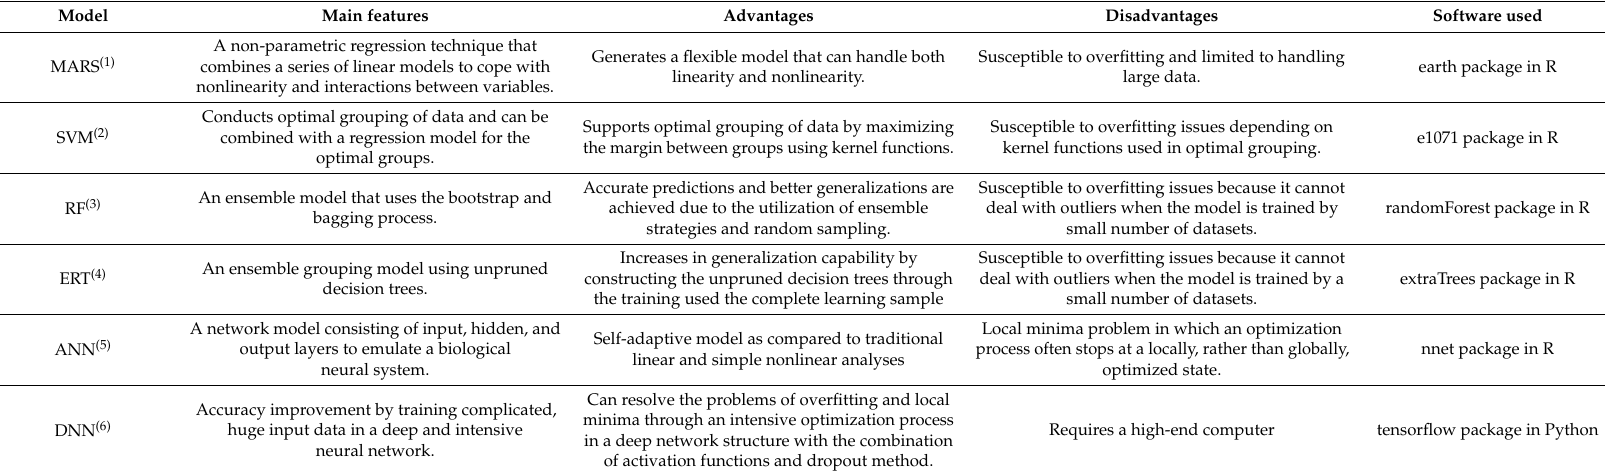
Table 3. Summary of the main features, advantages, disadvantages, and the software for the six major artificial intelligence (AI) models used in this